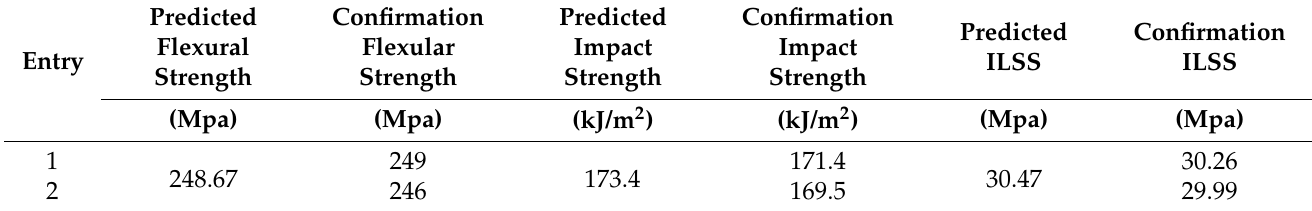
Table 9. Results of model validation at the optimum condition.